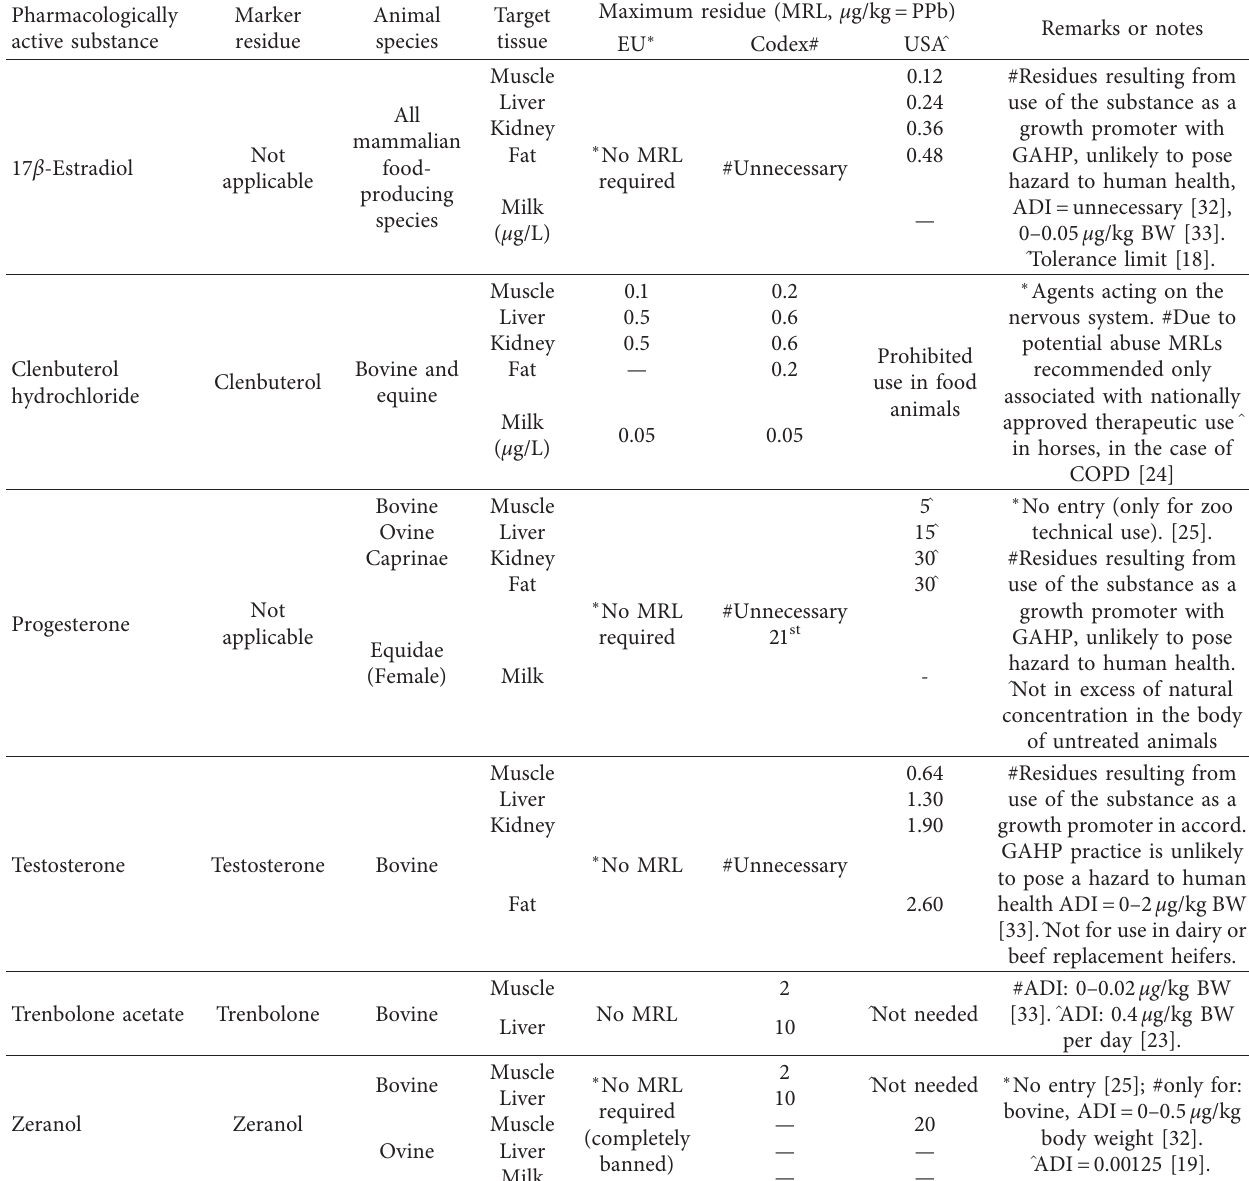
Table 2: Maximum residue limit (MRL) and ADI of different sequentially selected